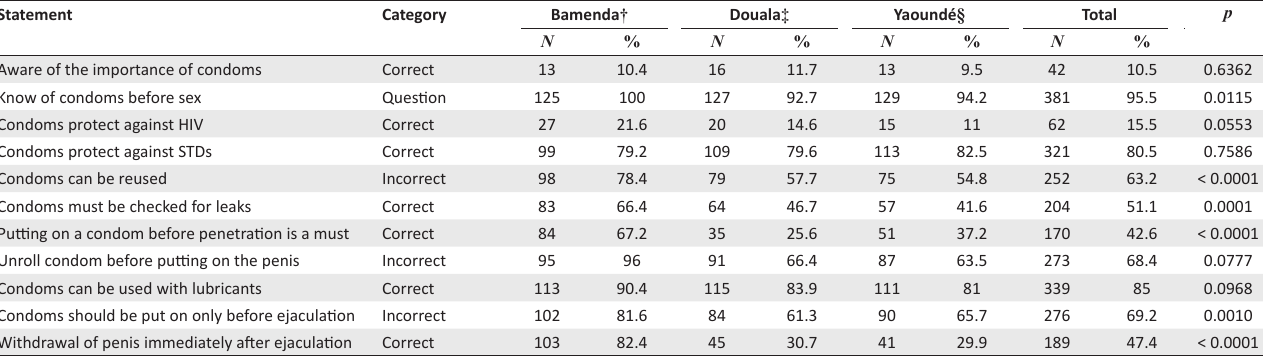
TABLE 2: Knowledge regarding condom use by